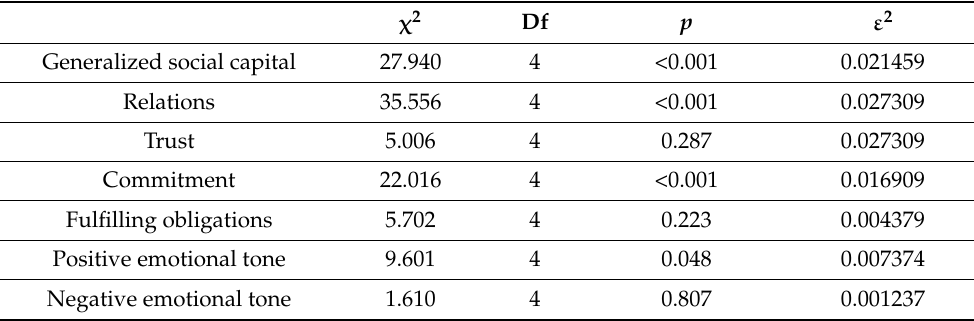
Table 3. Different educational stages compared according to the social capital and emotional tone of statements (Kruskal-Wallis test).